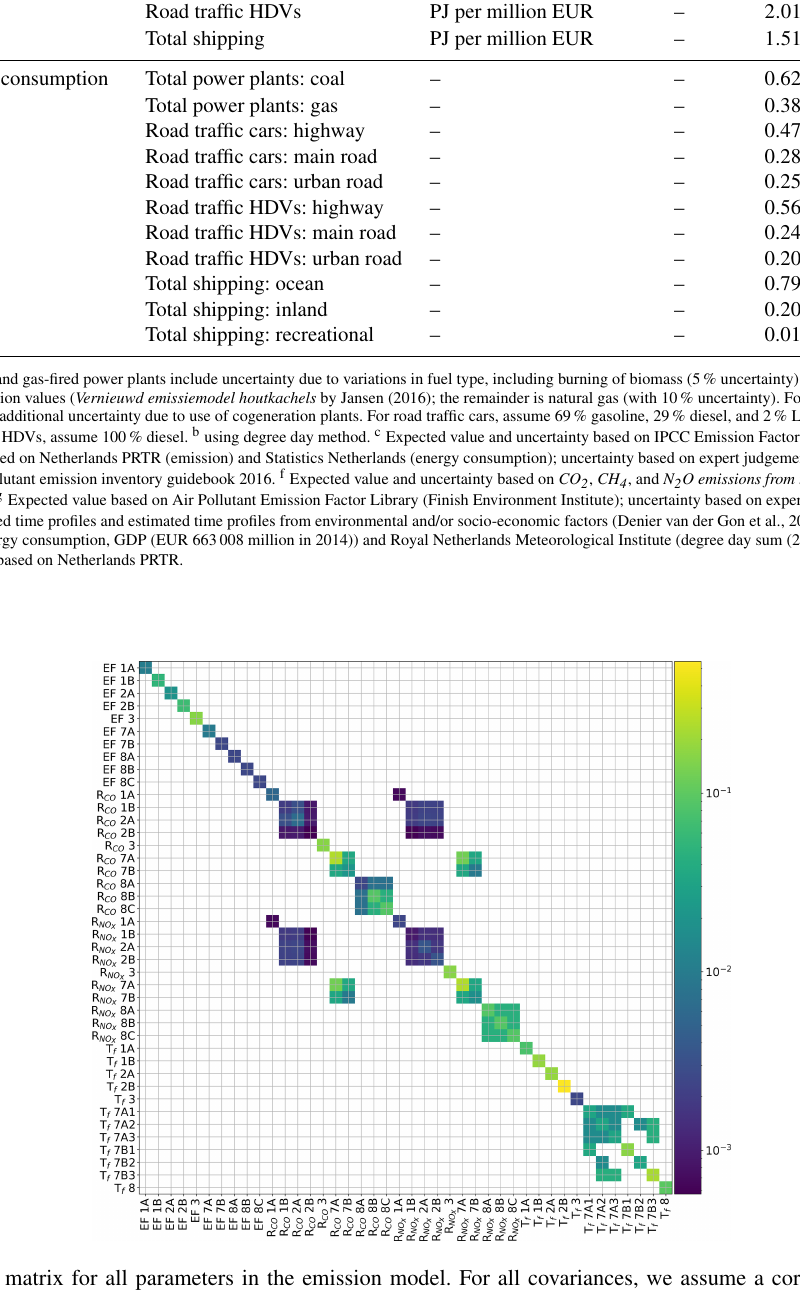
Figure A1. Covariance matrix for all parameters in the emission model. For all covariances, we assume a correlation coefficient of 0.5. (Sub-)sectors are indicated with their short names as summarized in Table 1. Note that the time profiles of road traffic emissions are specified per road type (1 = highway, 2 = main road, 3 = urban